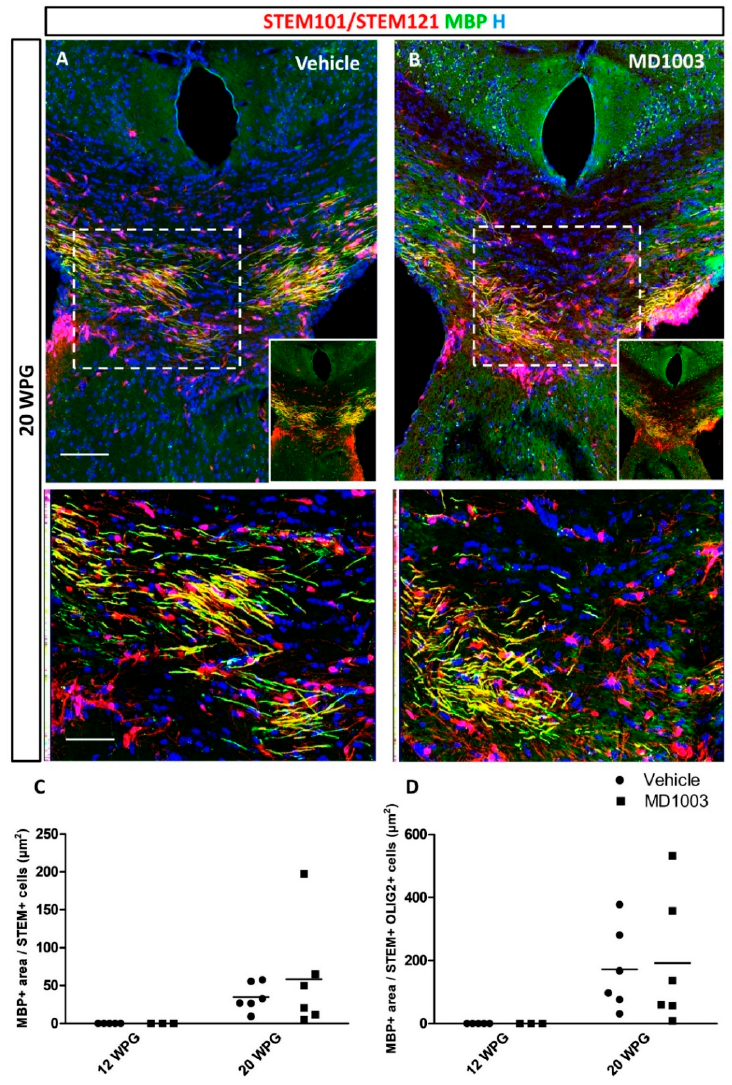
Figure 6. MD1003 does not increase the myelination potential of the hOPCs in vivo. ( A ) hOPCs (STEM101/STEM121 in red), although starting to differentiate as early as 12 wpg (see Figure 4), do not mature into MBP expressing cells (green) at this time point. ( A , B ) At 20 wpg they give rise to MBP+ mature oligodendrocytes (higher magnification of dotted boxes in the lower panel insets). MD1003 does not seem to increase the myelination potential of the grafted cells whether MBP is reported per total STEM+ cells ( C ), or total STEM+OLIG2+ OLs ( D ). Two-way ANOVA followed by Tukey’s multiple comparison ( n : 3–6 per groups). STEM101 (human nuclei marker); STEM121 (human cytoplasmic marker); WPG: weeks post graft, scale bars: 50 µ